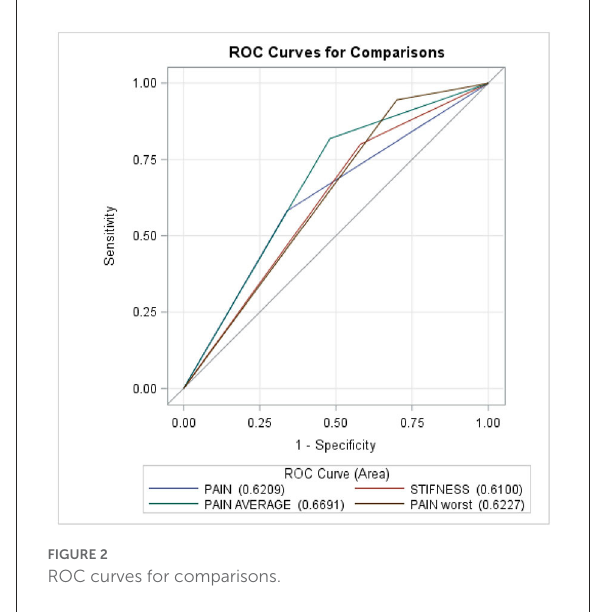
FIGURE2 ROC curves for comparisons.